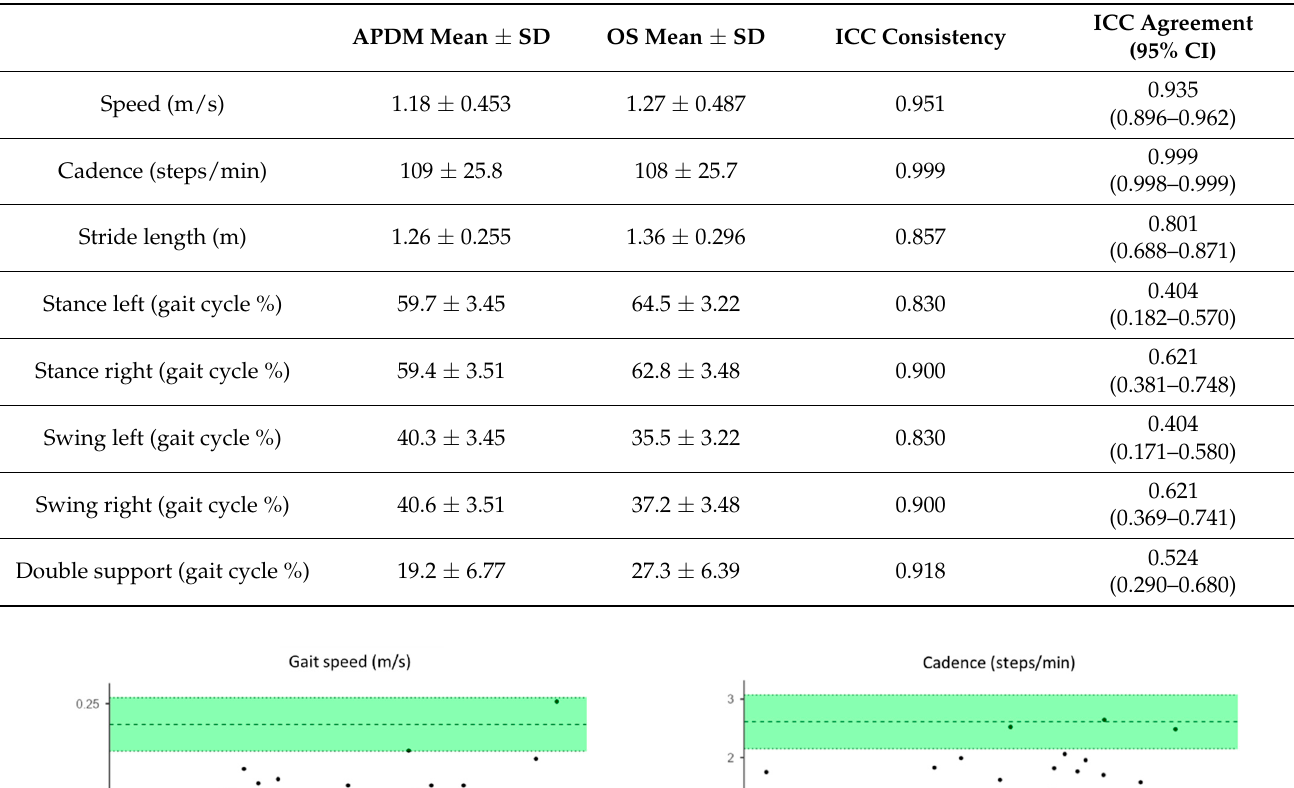
Table 1. Summary of results.